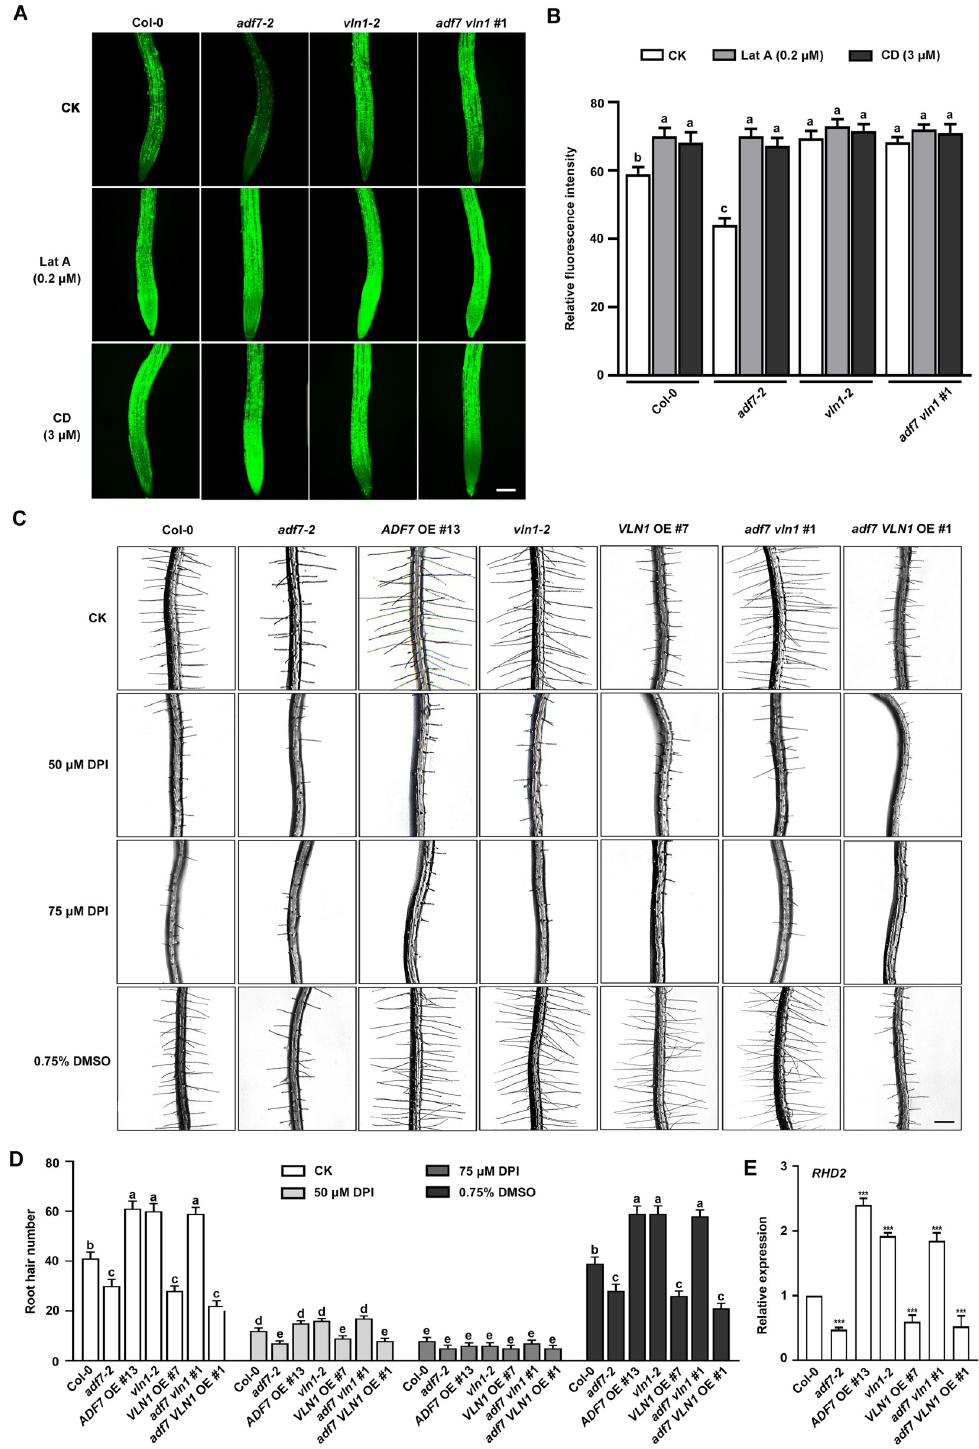
Fig 6. The F-actin depolymerization co-regulated by ADF7-inhibited-VLN1 elevates ROS accumulation during root hair formation. (A) Images of ROS levels in roots of Col-0, adf7-2 , vln1-2 , and adf7 vln1 #1 seedlings under Lat A treatments (0.2 μ M) and CD (3 μ M). Seedlings were treated with H2DCF–DA (see Methods ), scale bar, 100 μ m. (B) Histogram depicting relative fluorescence intensities of ROS accumulation in (A) At least 30 seedlings were examined for each material in different treatments. (C) Images of root hairs from Col-0, adf7-2 , vln1-2 , ADF7 OE #13, vln1-2 , VLN1 OE